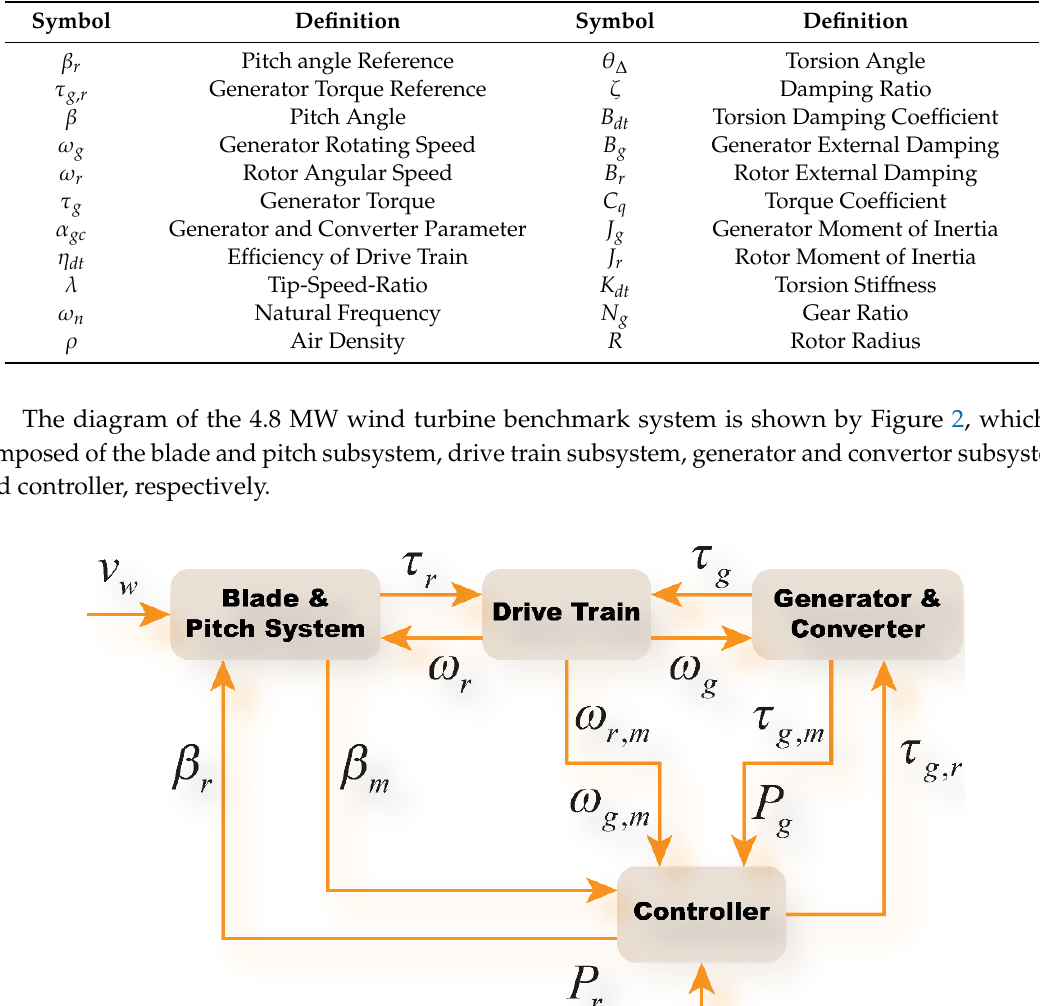
Table 1. Parameters of the 4.8 MW wind turbine benchmark system [43,44].